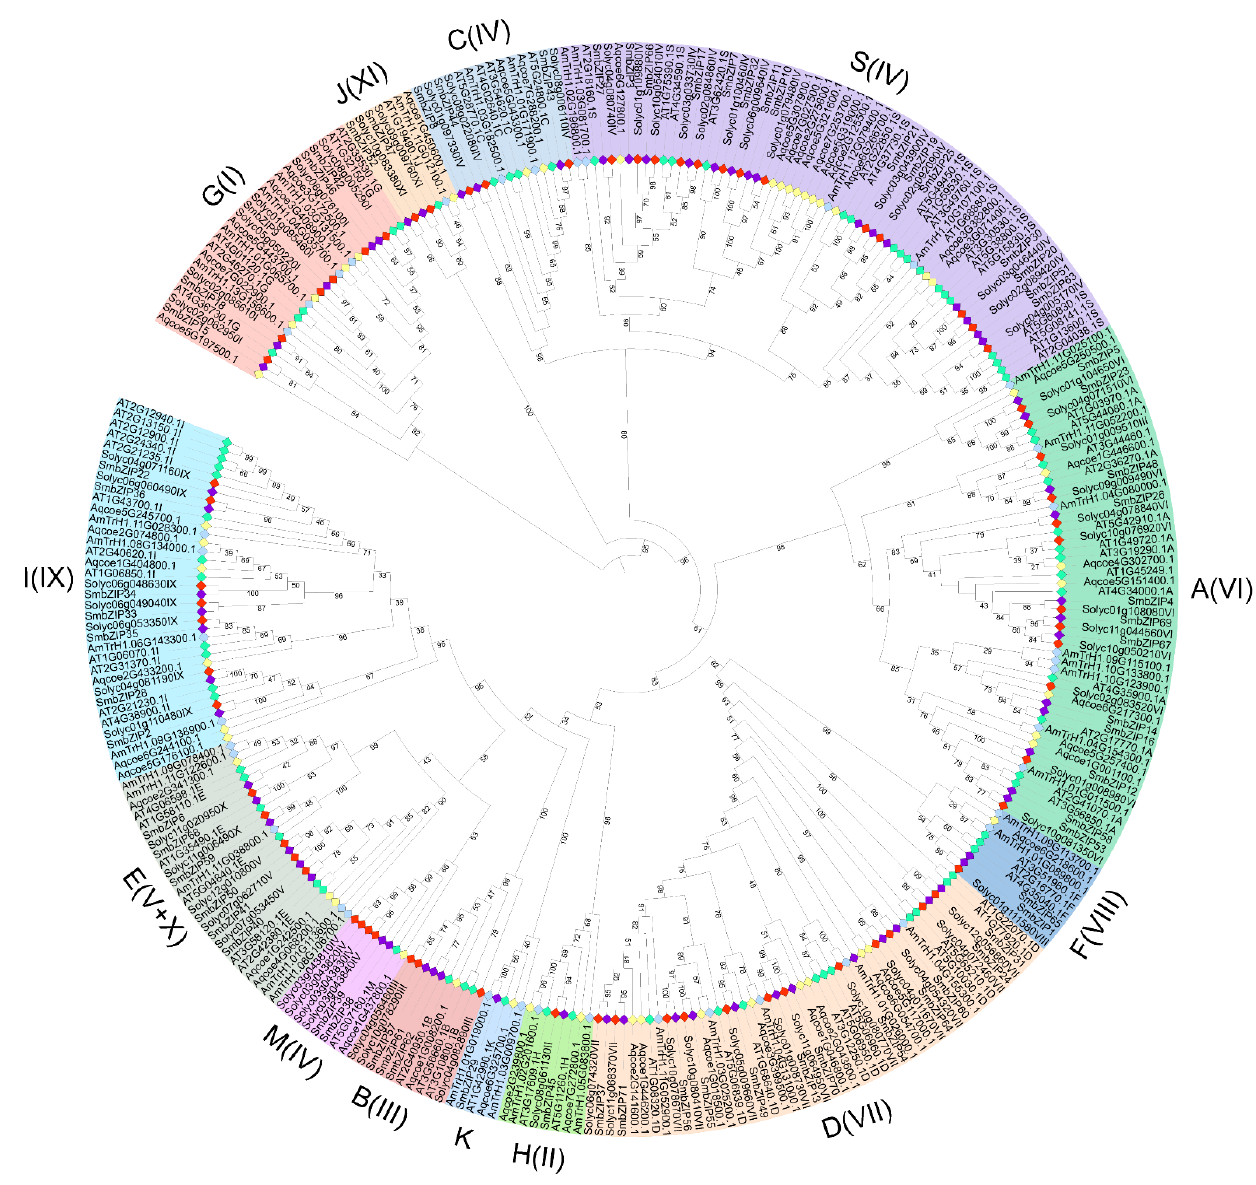
Figure 2. Phylogenetic analysis of bZIP proteins in eggplant, A. thaliana , S. lycopersicum , A. coerulea , and A. trichopoda . The phylogenetic tree was constructed using IQ-TREE with a bootstrap value of 5000. The phylogenetic tree was constructed based on the 306 bZIP domain sequences. The letters or roman numbers that follow the names of the S. lycopersicum or Arabidopsis bZIP genes denote categorization in previous studies. Table 1. The categorization of bZIP genes in five